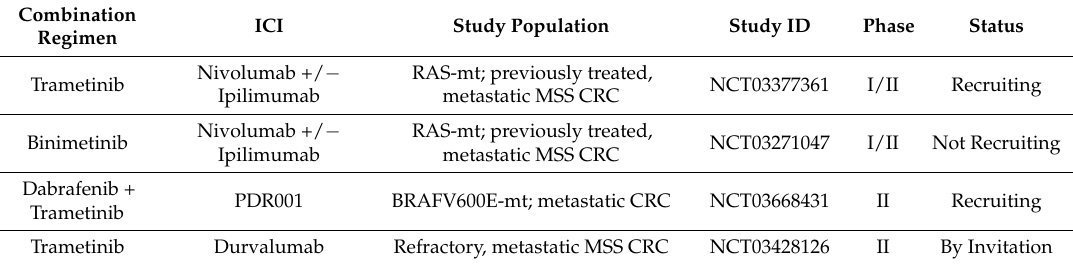
Table 4. Selected studies of combination ICIs and MEK inhibitors in